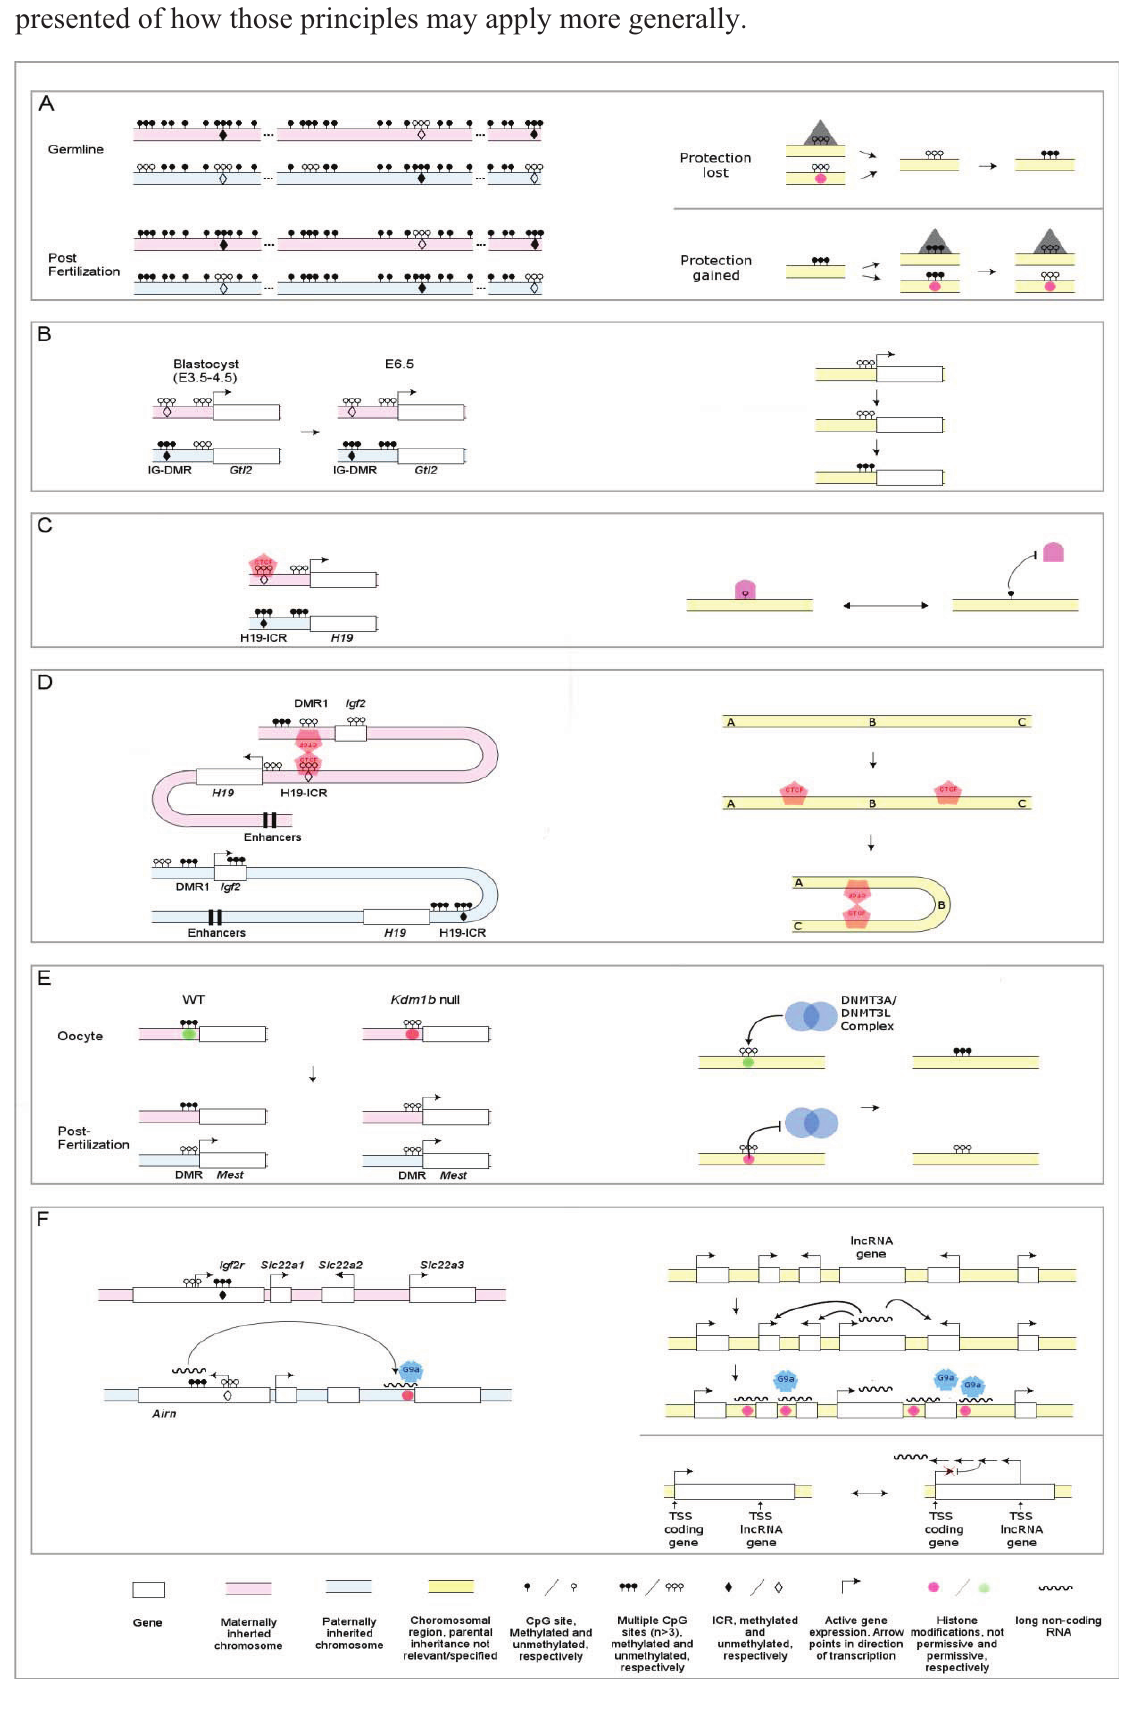
Figure 1. Regulatory epigenetic phenomena at imprinted loci. On the left are examples of various epigenetic mechanisms as observed in imprinted loci, and on the right models are presented of how those principles may apply more